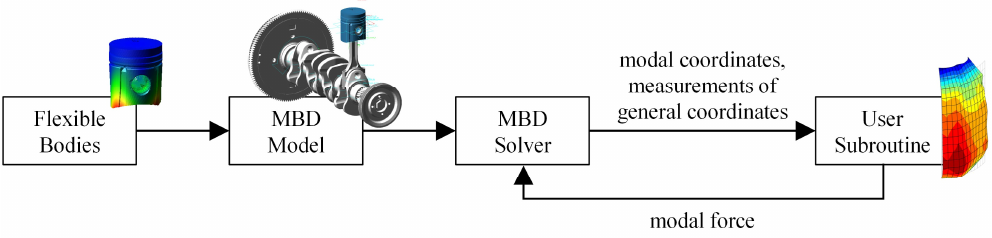
Figure 1. The MBD modeling procedure.